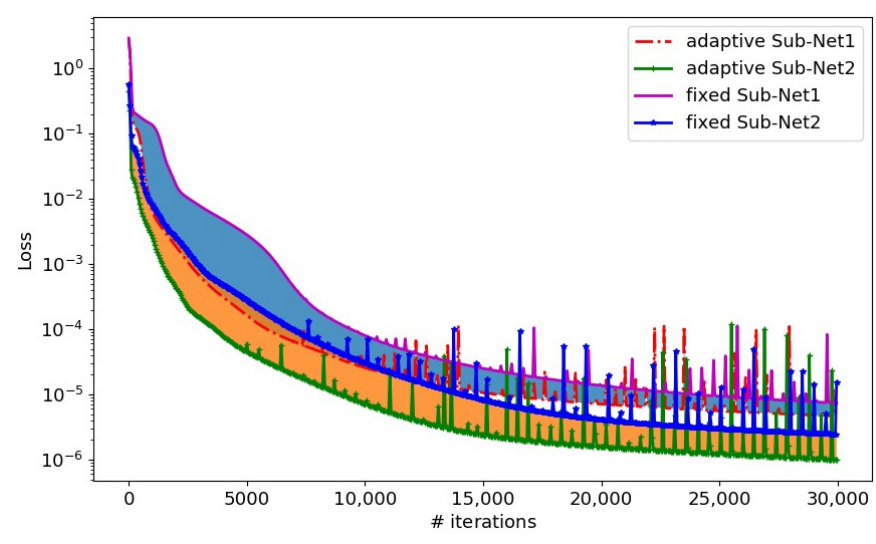
Figure 20. The evolution of L s average error loss for Example 6.